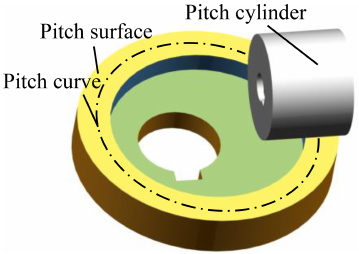
Figure 2. Pitch surfaces of NFG pair.